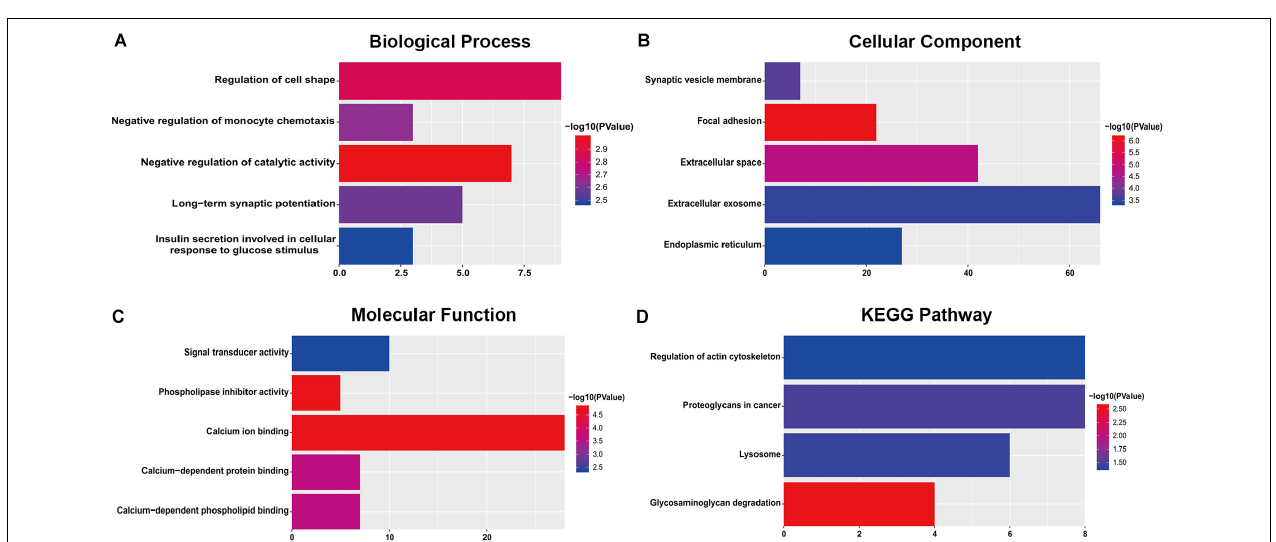
FIGURE 1 | Identification of DEGs among TCGA and GEO datasets of GBM. (A) Volcano plots of DEGs in TCGA dataset. (B) Volcano plots of DEGs in GSE7696 dataset. (C) The Venn diagram of overlapping DEGs among TCGA and GSE7696 datasets.